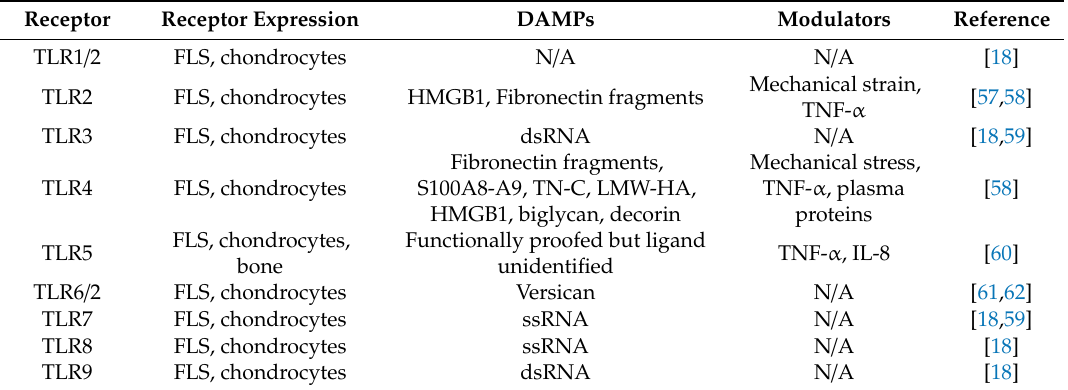
Table 1. Toll-like receptors and their respective endogenous ligands present in osteoarthritis. Receptor Receptor Expression DAMPs Modulators Reference